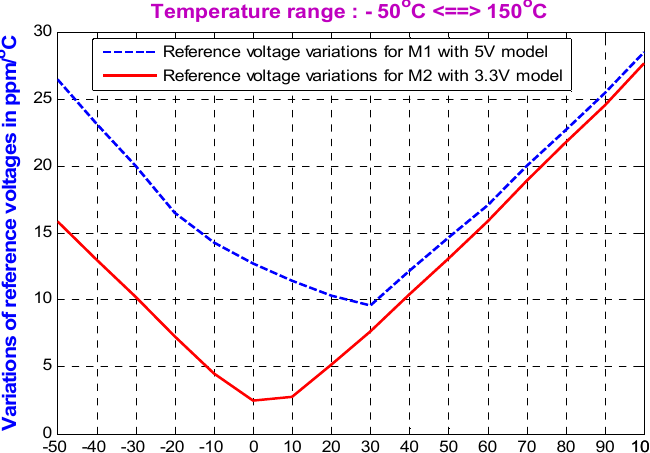
Figure 4. The variations of voltage reference due to the temperature variation of R . Temperature range : - 50 o C <==> 150 o C Reference voltage variations for M1 with 5V model Reference voltage variations for M2 with 3.3V